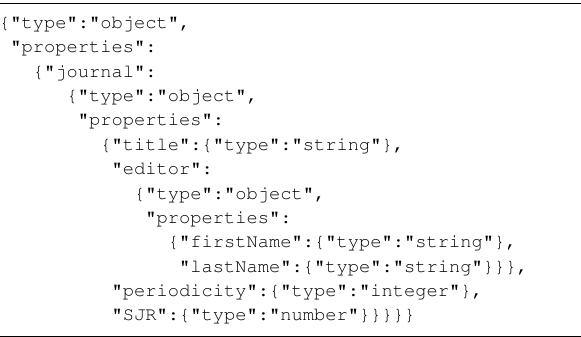
Fig. 8 The generated JSON Schema of